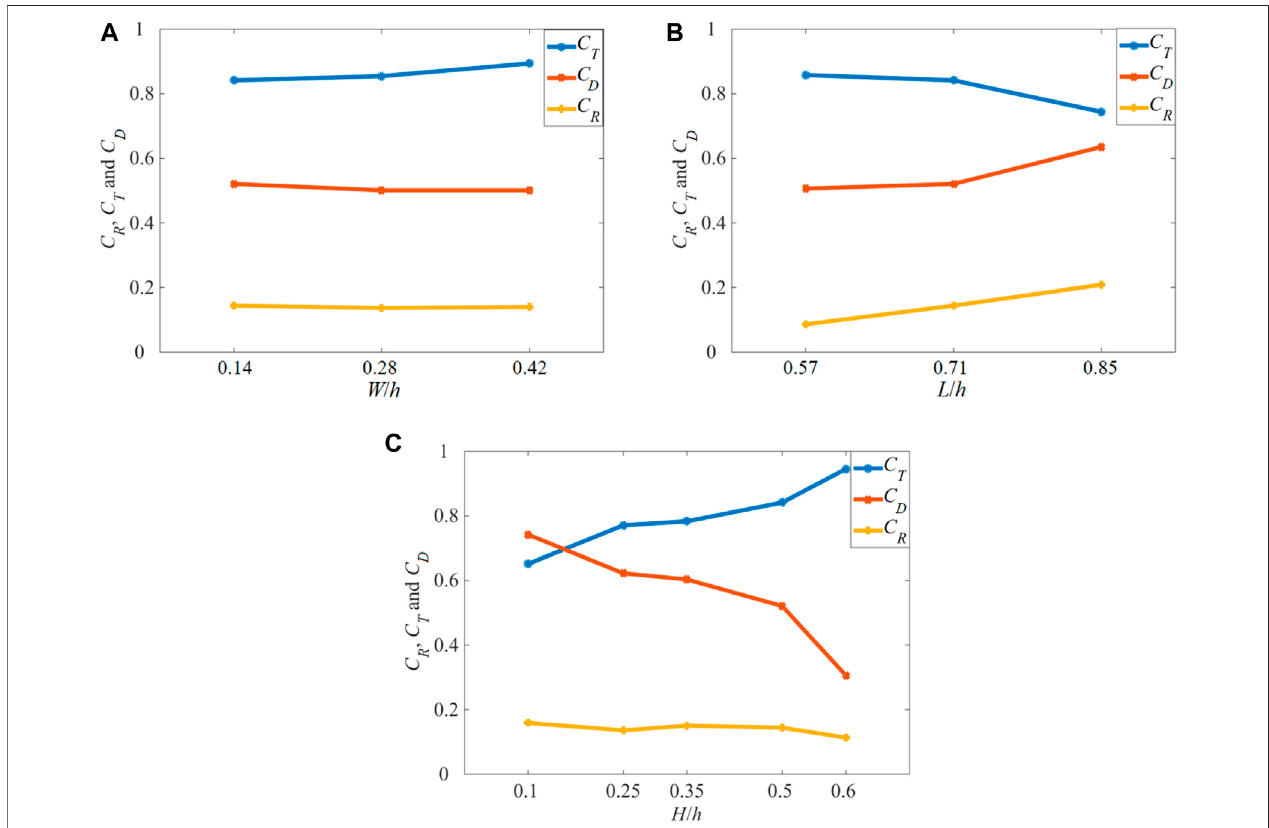
FIGURE 13 | Coef fi cients of wave re fl ection C R , transmission C T , and dissipation C D vs different barrier (A) width W ; (B) height L ; and (C) incident wave height H .